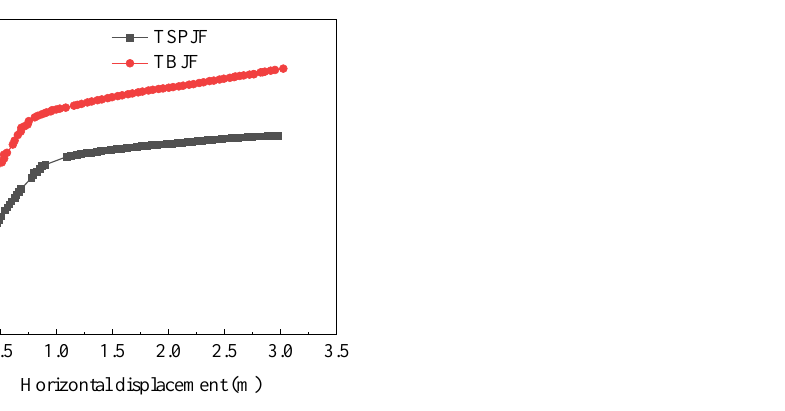
Figure 11. Horizontal load – displacement curve of the TSPJF and TBJF at the loading points.